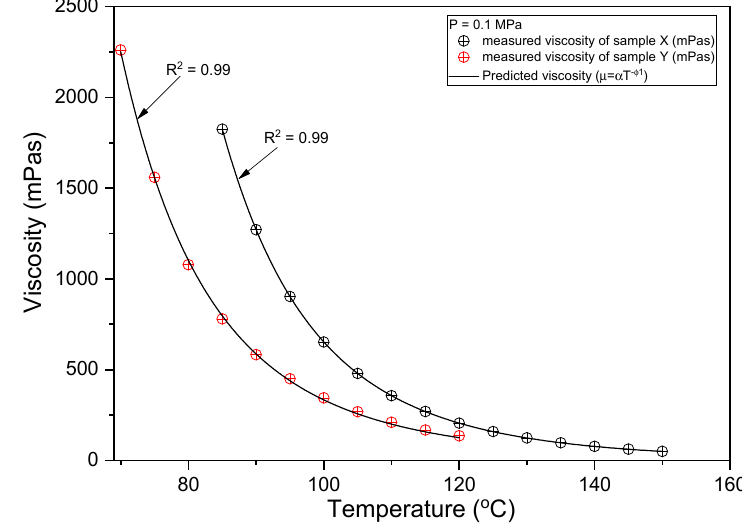
Figure 3. Viscosity of bitumen samples at different temperatures and atmospheric pressures.